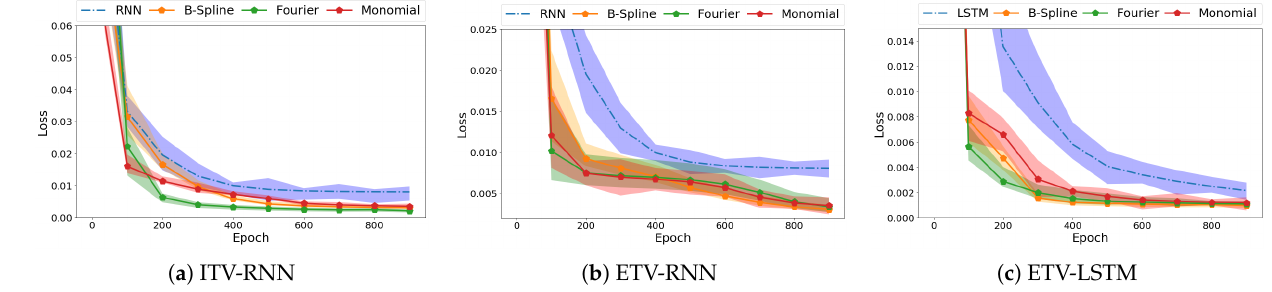
Figure 6. The impact of basis function types (B-spline, Fourier, and monomial) on model performance using Data S9. The shaded region denotes the loss range of five-fold cross-validation and the solid line is the average